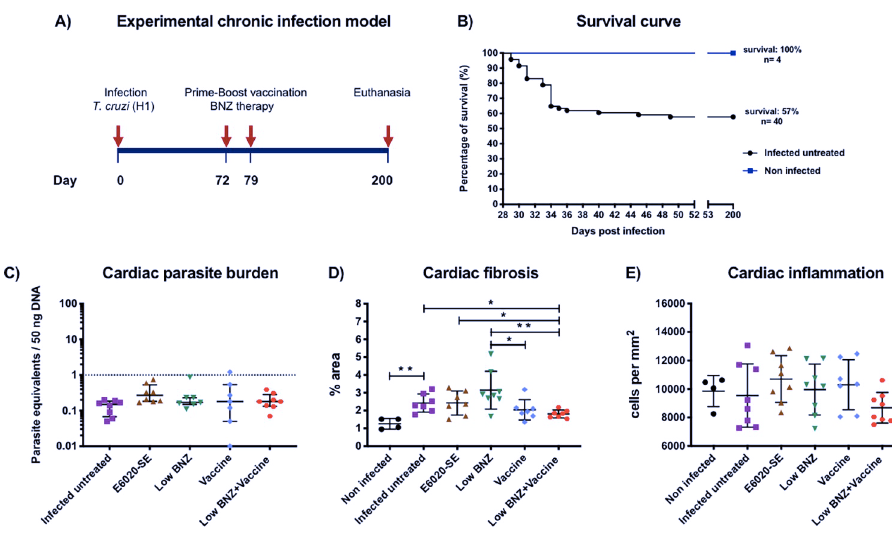
Fig 1. Protective effect of the vaccine-linked chemotherapy. (A) Timeline for experimental infection. A total of 70 BALB/c mice were infected with 500 trypomastigotes of T . cruzi (H1 strain) by intraperitoneal injection. Four mice were included as non-infected control group and received only saline solution. At day 200 p.i mice were euthanized, and tissues samples were collected. (B) Survival curve. Survival was monitored during 200 days post-infection. ( C ) Cardiac parasite burden was quantified by quantitative real-time PCR. The dotted line represents the cut-off for the limit of detectable quantification (LOQ) based on serially diluted T . cruzi -enriched cardiac tissue DNA (1 parasite equivalents per 50 ng of DNA). Each point represents an individual mouse; horizontal lines denote median ± interquartile ranges values; significance calculated by Kruskal-Wallis test with Dunn’s correction for multiple comparisons. ( D ) Percentage fibrosis area for all experimental groups. The cardiac fibrosis was quantified from representative images of Masson´s trichrome-stained tissue sections using Image J software. Each point represents an individual mouse, horizontal lines denote means ± SD; significance between two groups was calculated by Student´s t-test. ( E ) Infiltrate cells/mm 2 for all experimental groups. Cardiac inflammation was quantified from representative images of H&E-stained tissue sections using Image J software. Each point represents an individual mouse, horizontal lines denote means ± SD; significance was calculated by ANOVA test. Significance is indicated as follows � , P � 0.05; �� , P �